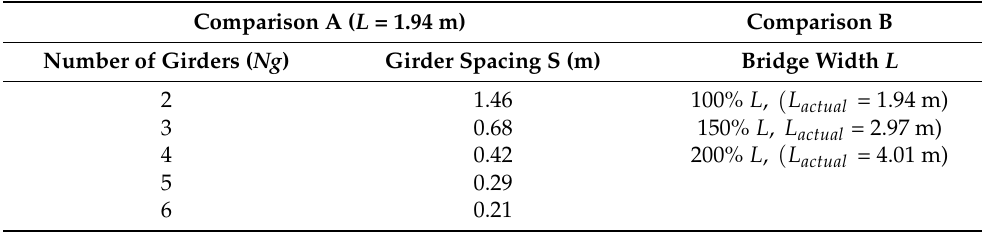
Table 1. Summary of the bridge deck configurations.